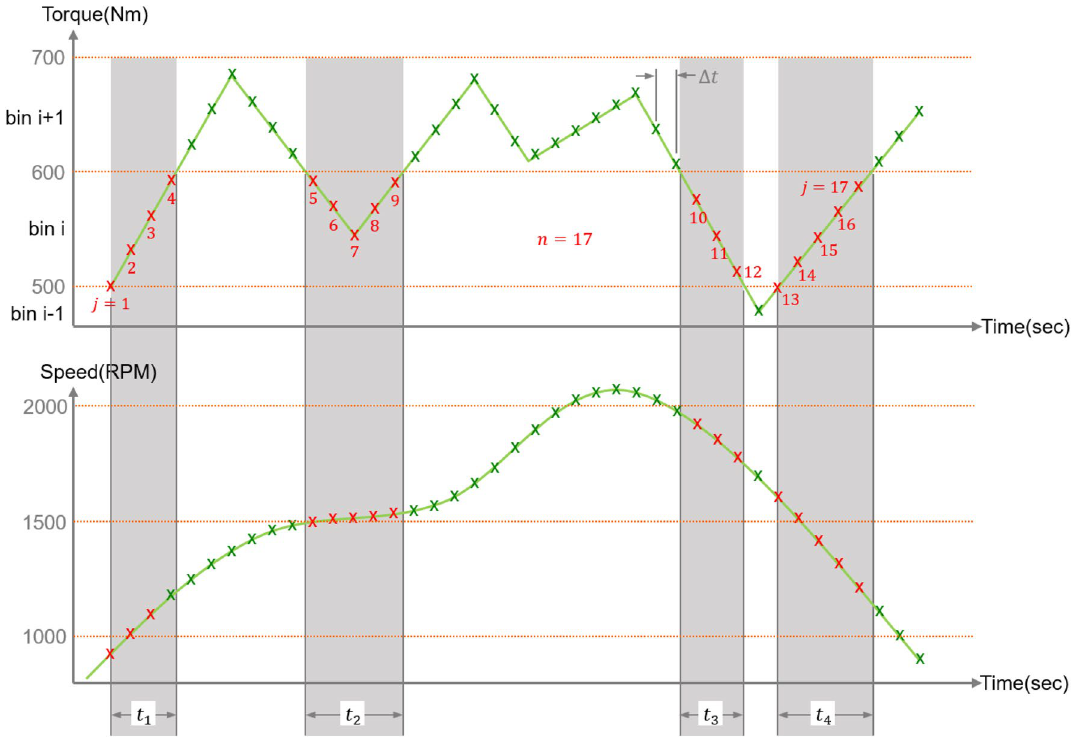
Figure 1. Sample data for explaining LDD method.